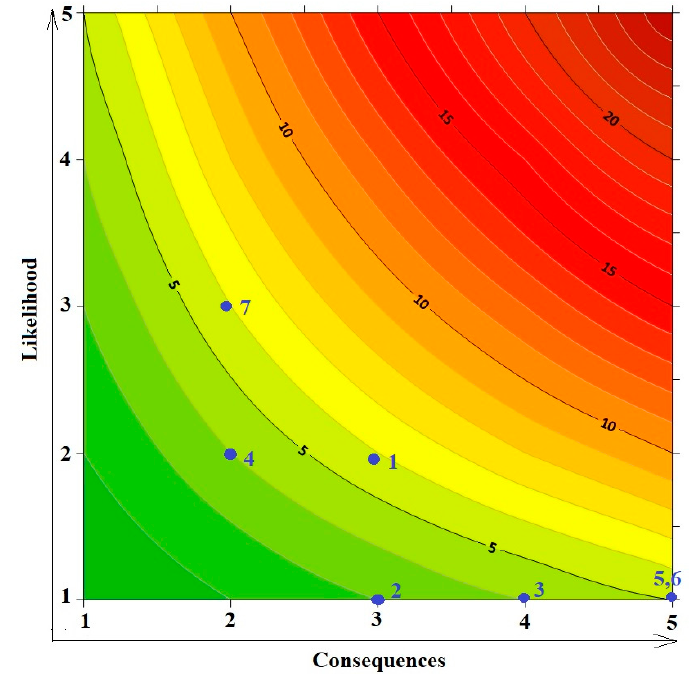
Figure 3. Risk heat map for environmental impacts of CBM exploitation.